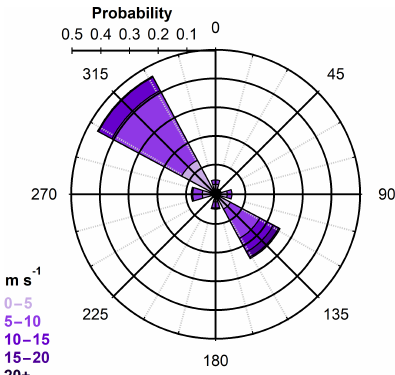
Figure 2. Rose plot for wind data during INCAS. Values correspond to wind direction binned by 45 ◦ and wind speeds binned by 5ms − 1 . The probability for wind speed to fall within these bins is